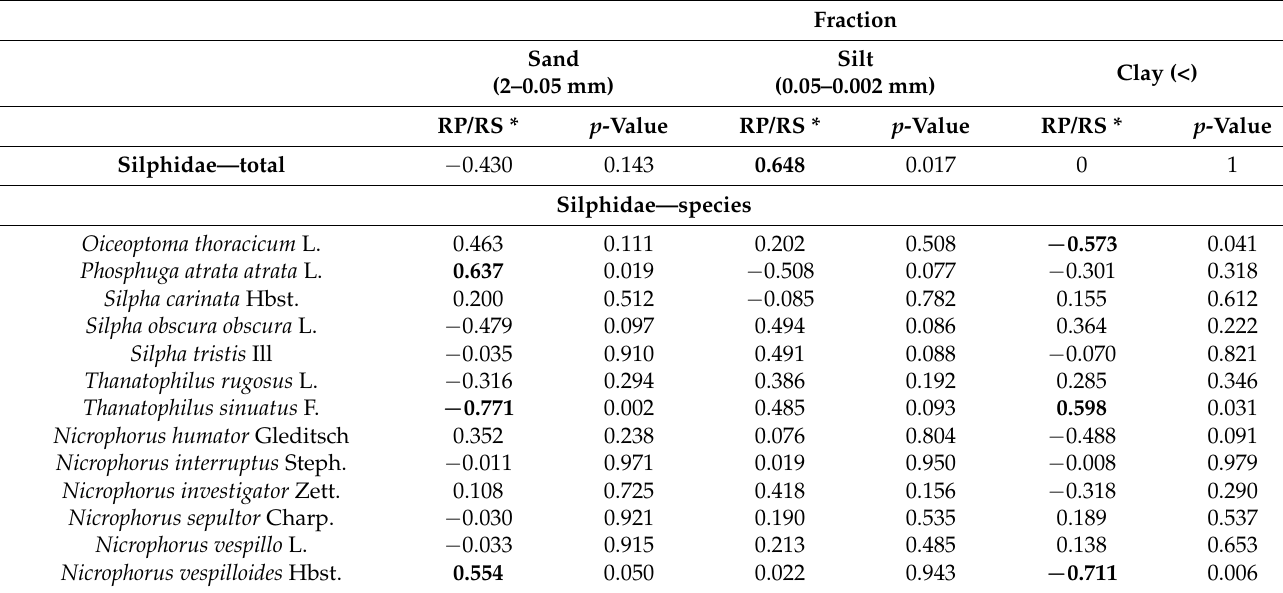
Table 3. The results of the correlation between the number of Silphidae and the percentage content of individual fractions in the soil